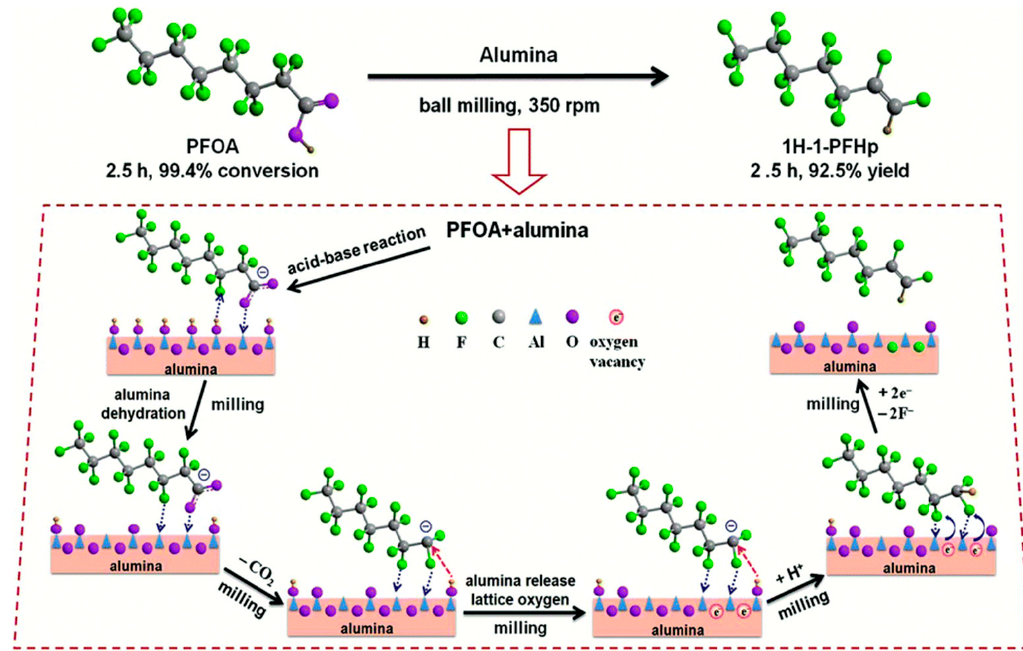
Figure 5. Proposed mechanistic steps for the alumina-mediated activation of PFOA (reproduced from [120] with permission from The Royal Society of Chemistry).